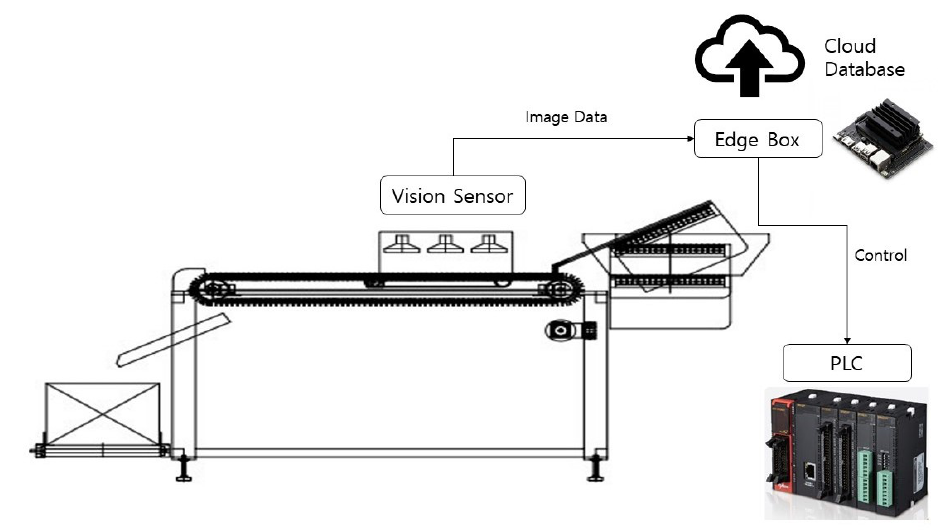
Figure 1. System Architecture.